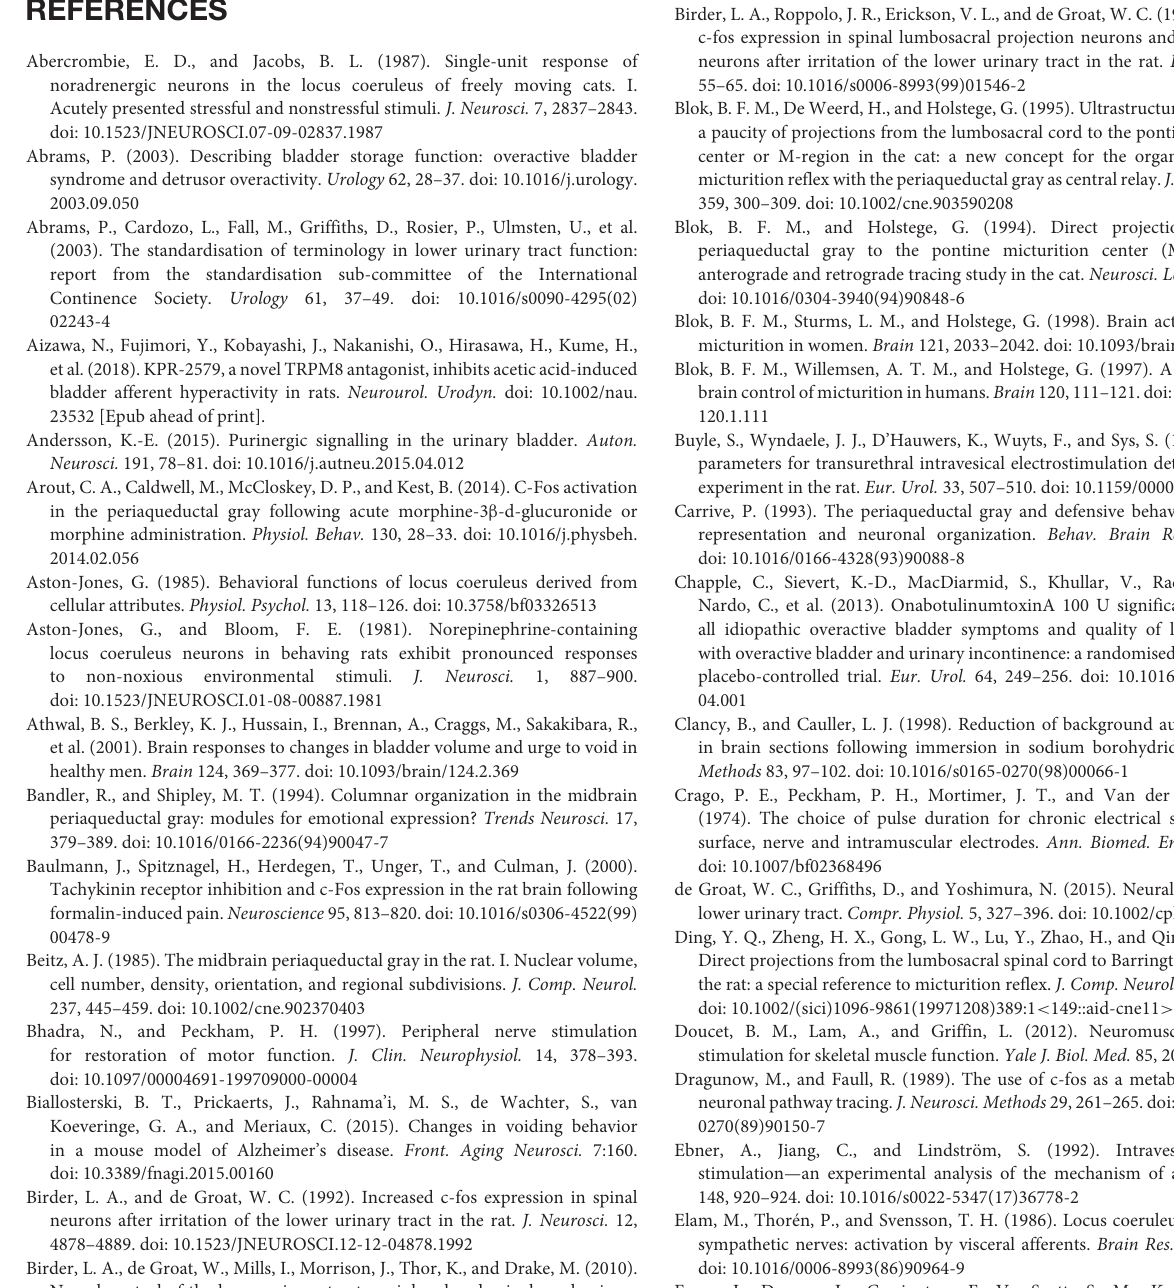
FIGURE S1 | Schematic diagram of the dorsomedial (dm), dorsolateral (dl), lateral (l) and ventrolateral (vl) longitudinal neuronal columns of periaqueductal gray matter (PAG) along the rostro-caudal axis (from left to right on the figure) and associated representative photomicrographs of coronal brain sections stained for